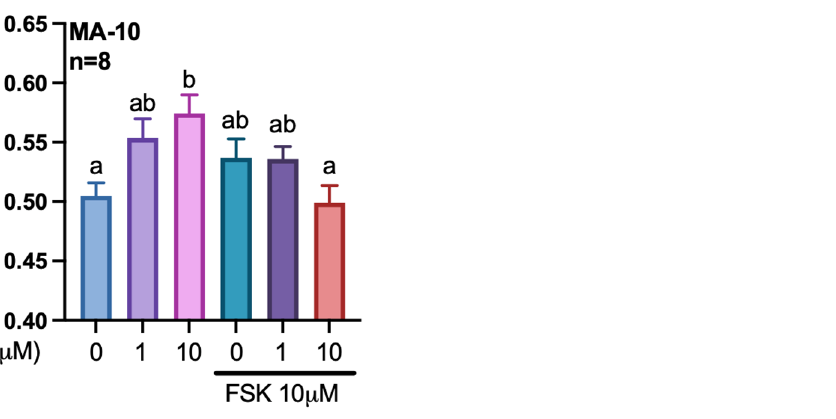
Figure 6. Changes in the accumulation of lipid droplets in response to gigantol treatment of MA-10 Leydig cells. Following treatments of MA-10 Leydig cells with gigantol (1, 10 μ M) in the presence or absence of 10 μ M forskolin (FSK) for 4 h, lipid droplets were quantified using Nile Red staining. Results are normalized using Hoescht DNA staining. A two-way ANOVA followed by a Holm-Sidak multiple comparison test was used to analyze data. Different letters indicate significant differences ( p < 0.05).